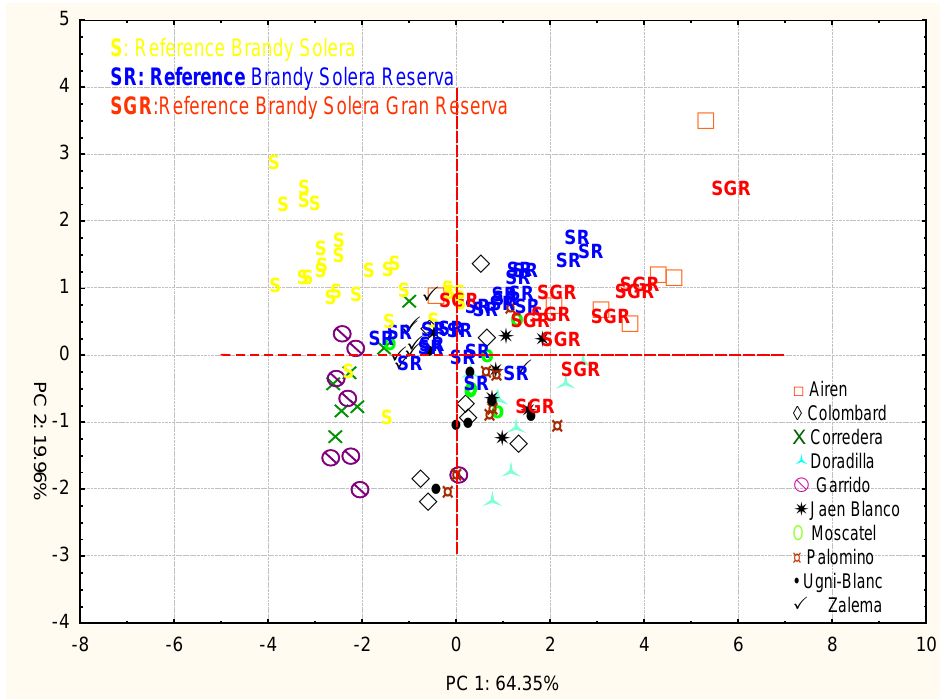
Figure 7. Principal component analysis with distillates of different varieties of grapes aged by an accelerated method and traditional method. Projection of the cases on the factor plane.